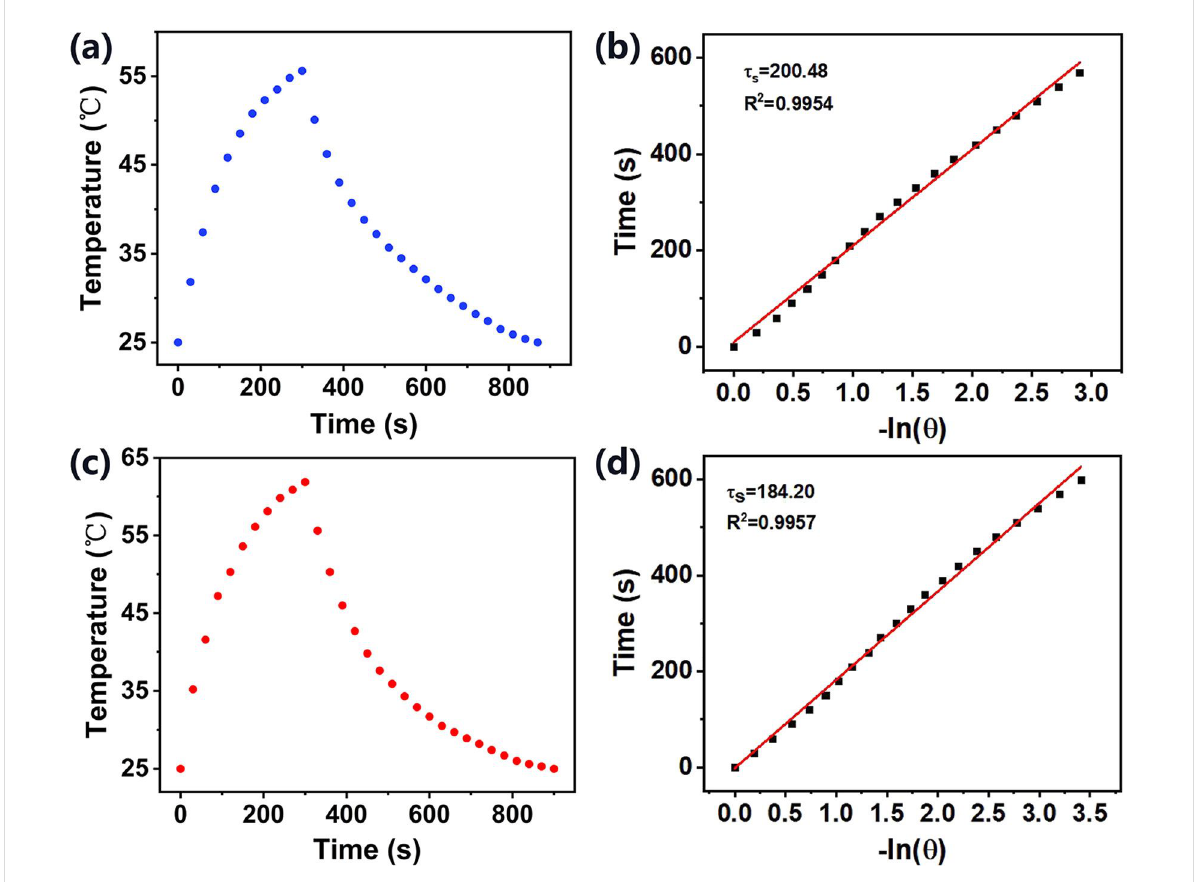
Figure 6: Heating and cooling curves of (a) AuNRs and (c) Au@Pt NRs under 808 nm laser irradiation. Linear fit of the time vs − ln θ obtained from the cooling period of the (b) AuNRs and (d) Au@Pt NRs heating experiments.